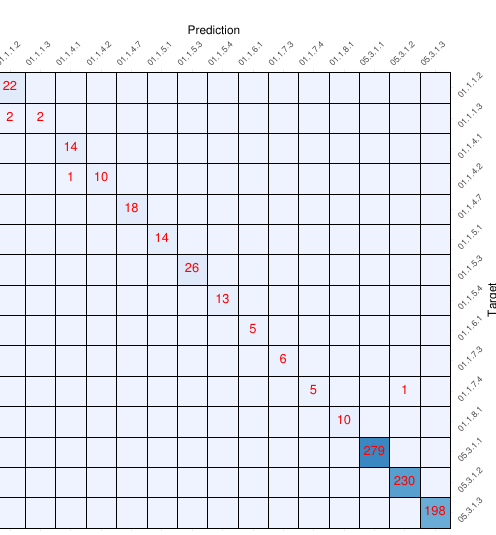
Figure 11. The confusion matrix for logistic regression using the FastText skip-gram